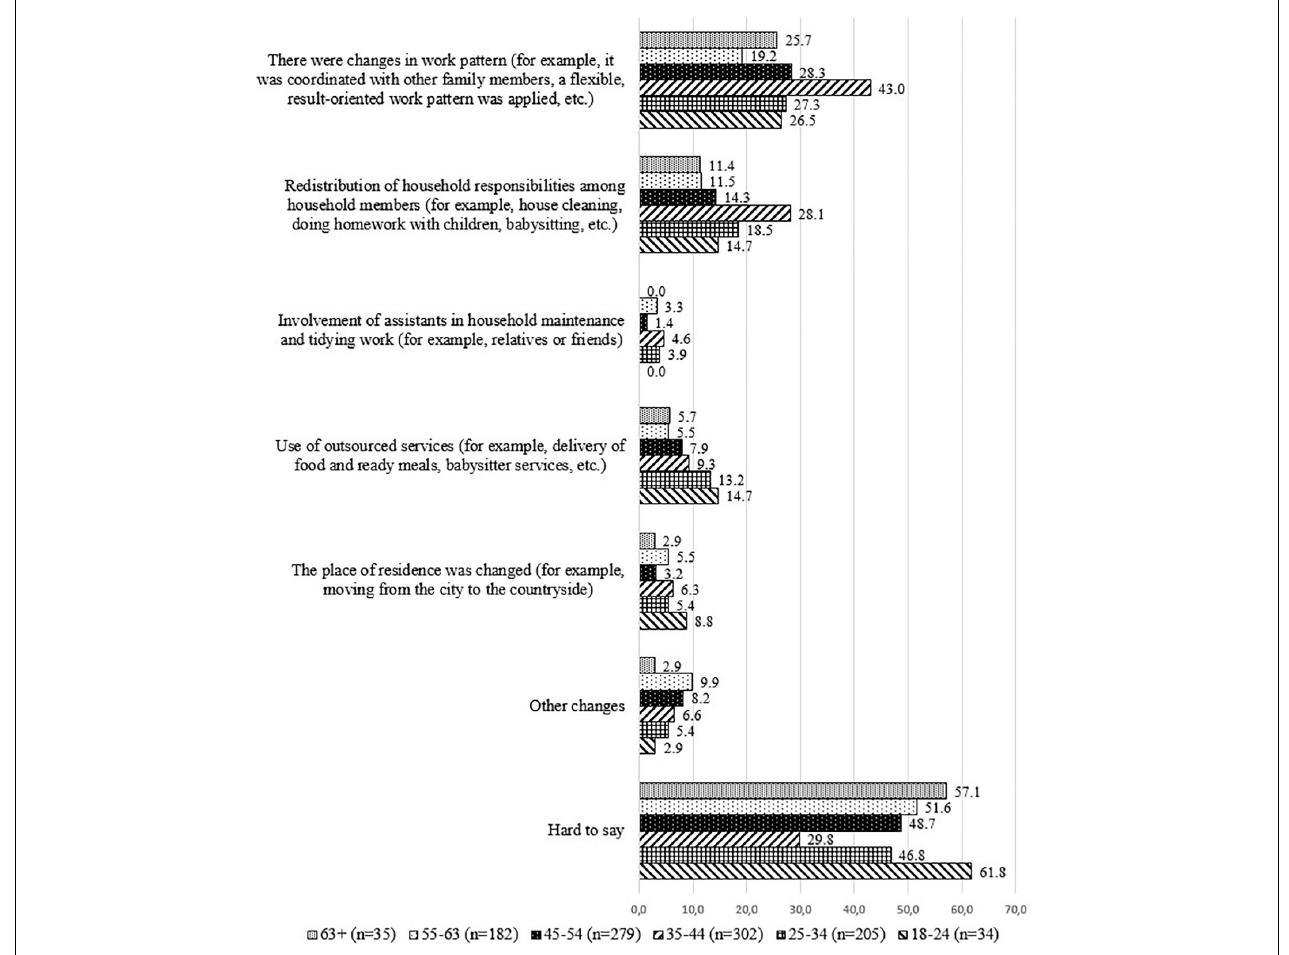
FIGURE 3 | Distribution of answers of employed respondents to the question “Please mark what changes were made to your household’s daily routine during COVID-19 to enhance work–life balance?”; age groups;